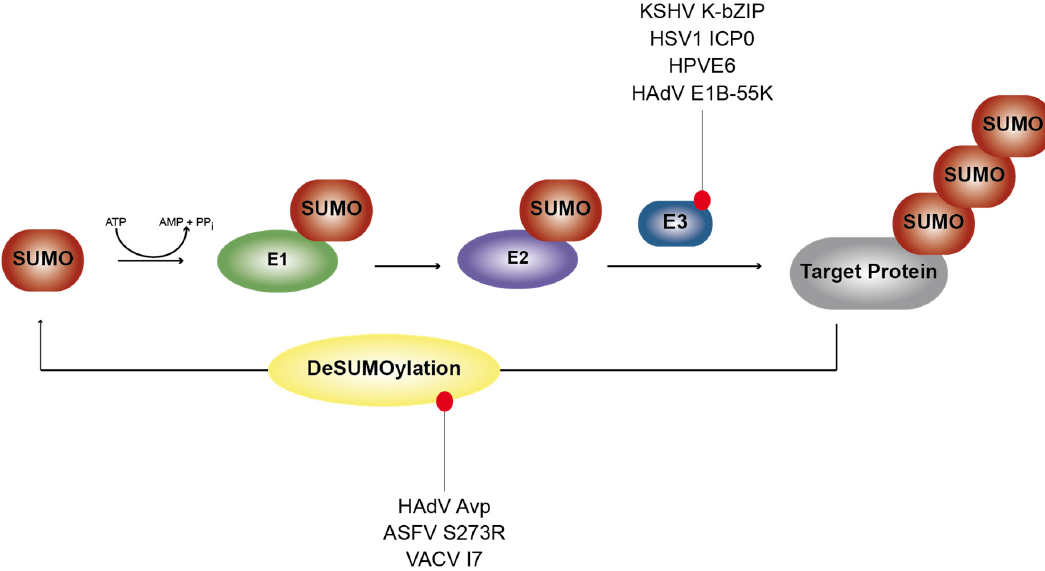
Figure 2. Overview of some viruses that modulate host SUMOylation pathways. Listed are viruses known to encode proteins exhibiting functions of cellular regulatory proteins involved in SUMOylation. Described in detail in the text.